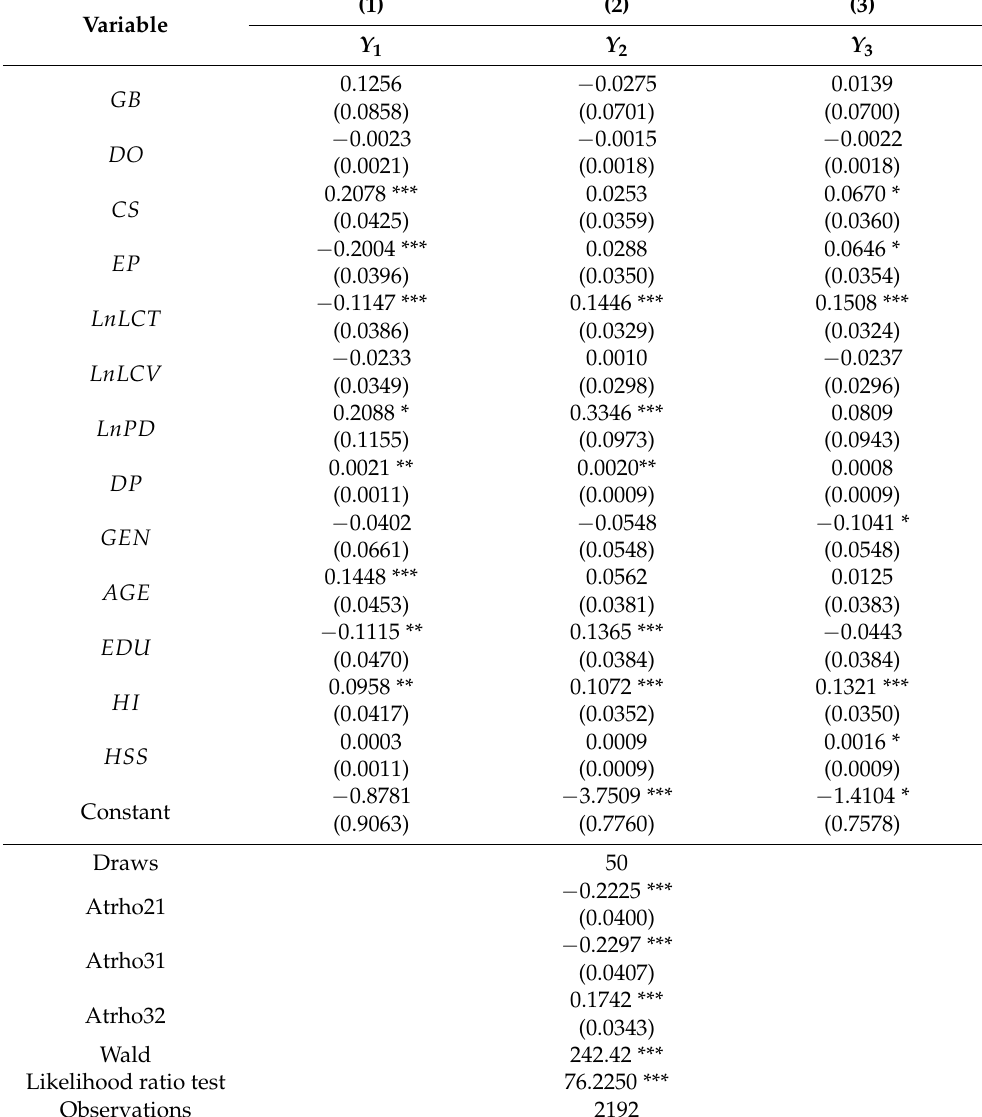
Table 6. Heterogeneity regression results of resident status’ impact.